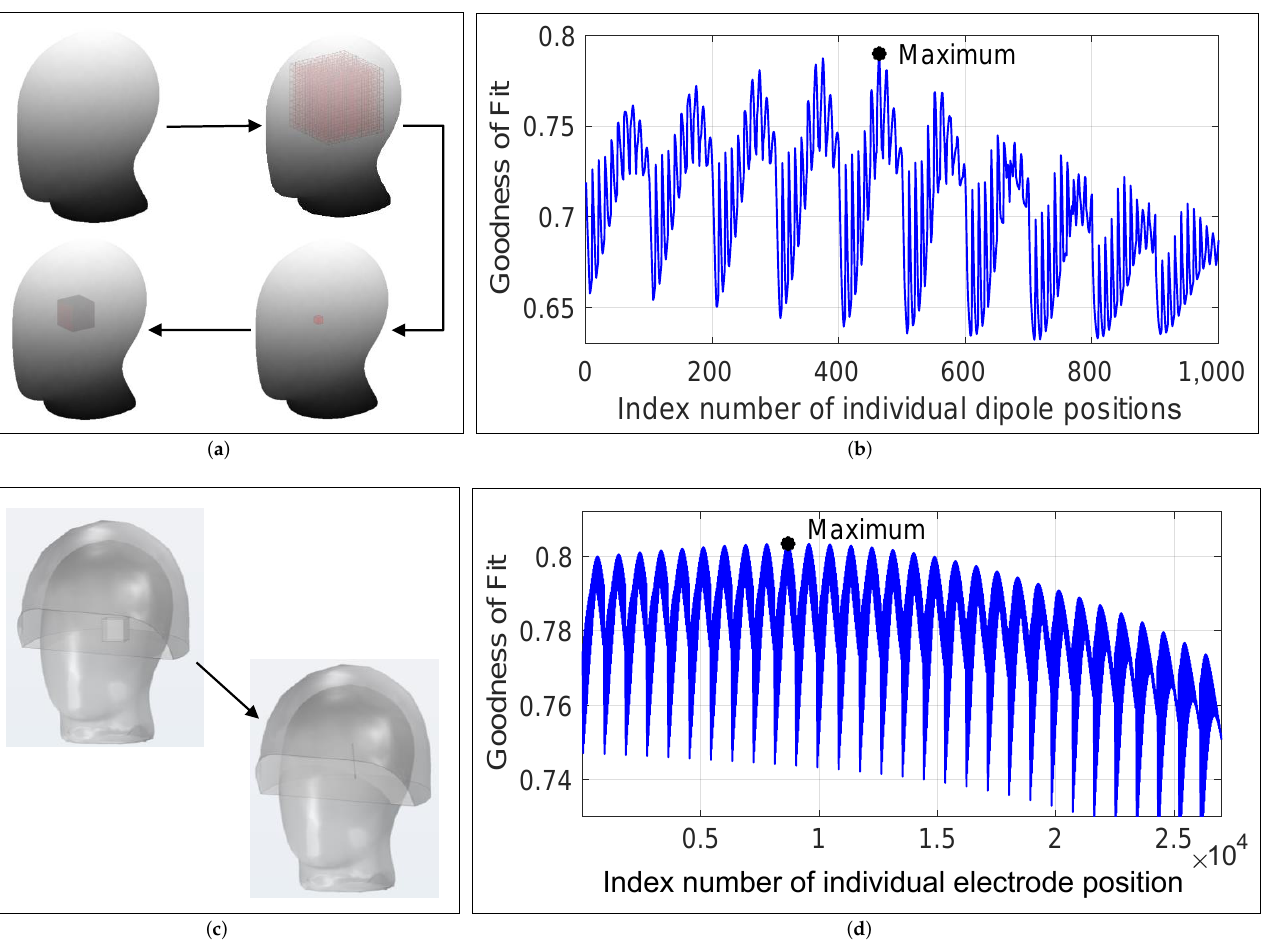
Figure 10. ( a , c ): Schematic representation of the procedure for pre- and post-localization of the electrode. ( b , d ): GoF values between modeled and measured data, with 1000 positions for the dipole in the simplified dipole model and 27,000 positions for the electrode in the electromagnetic